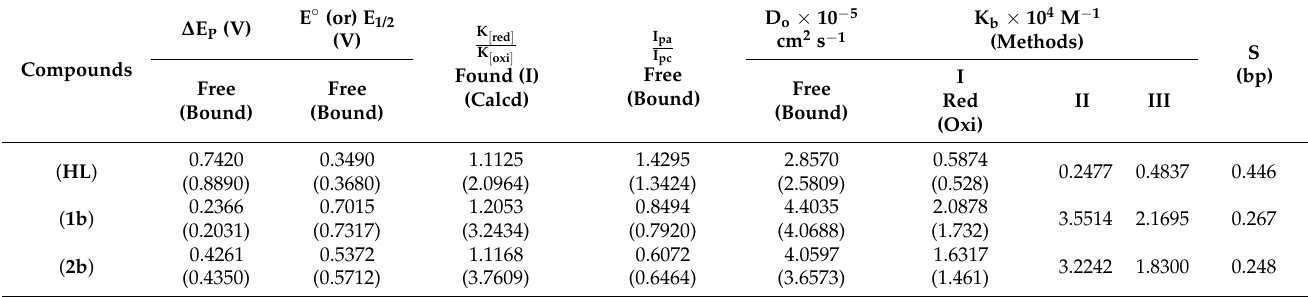
Table 6. The redox potential profiles for interaction of CT-DNA with complexes ( 1b – 2b